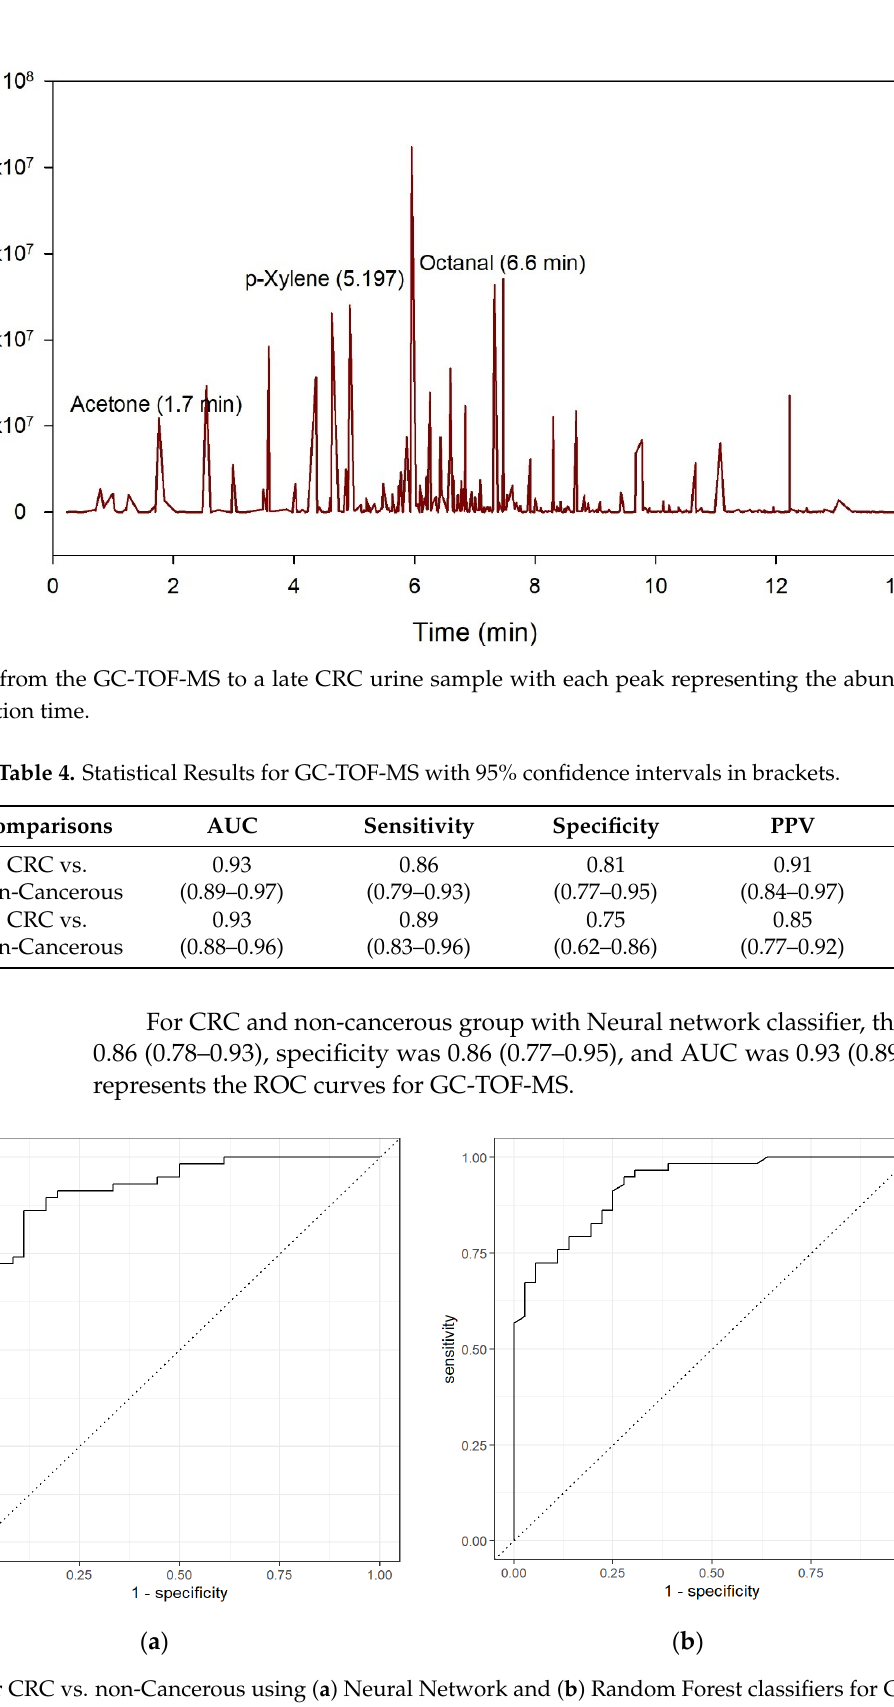
Table 5. VOCs obtained from GC-TOF-MS data analysis using the TOF-DS software. S. No.